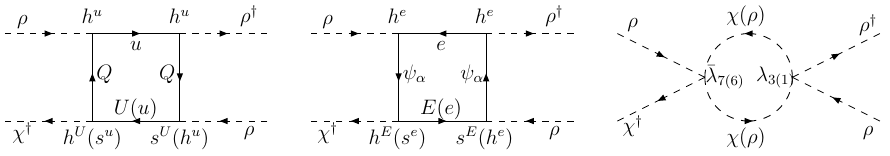
Figure 1 . Dominant one-loop contributions to the (cid:22) (cid:21) 6 coupling, where each diagram-type has an additional contribution with parenthesized (cid:12)elds and